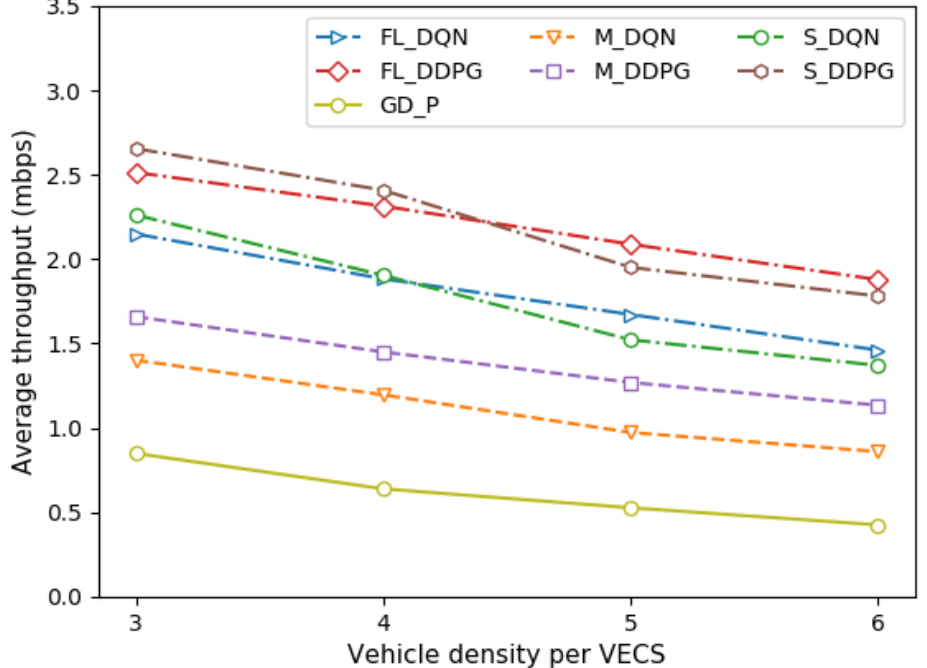
Figure 4. Comparison of average throughput under different vehicle densities.